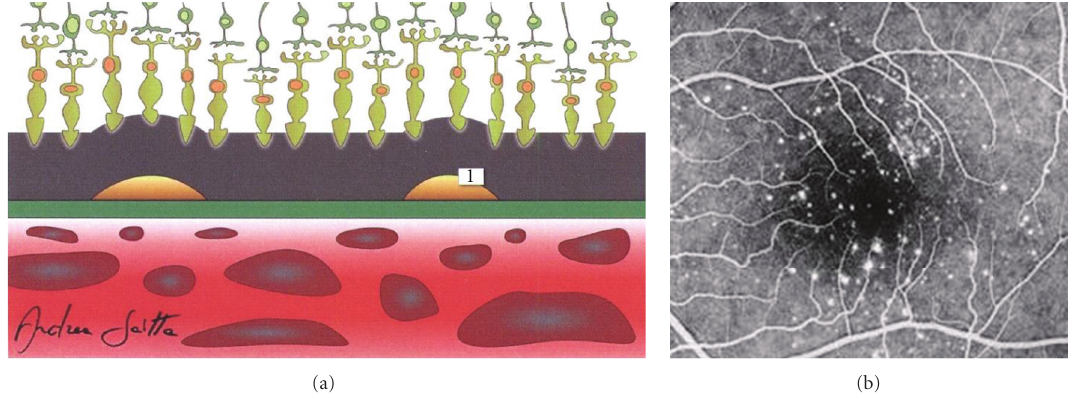
Figure 2: Early age-related macular degeneration. (a) Schematic cross-sectional illustration of the macula with an early stage of the disease ((1) drusen). (b) Fluorescein angiography of the macula a ff ected by an early form of the disease (nonconfluent hard drusen); in this eye, the best best-correct visual acuity was 20/20 (Snellen equivalent) (extracted and modified from [4]).